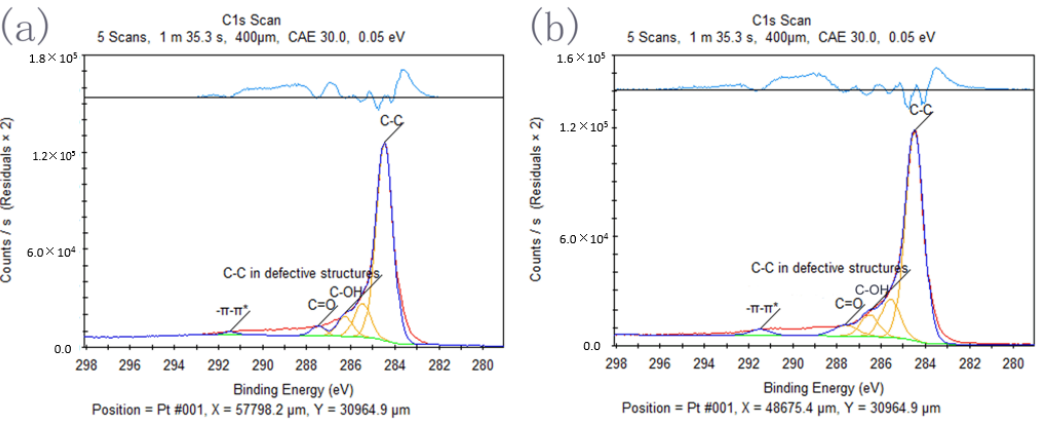
Figure 6. C1 s X-ray photoelectron spectroscopy (XPS) spectra of rGO ( a ) and GESA3 ( b ).